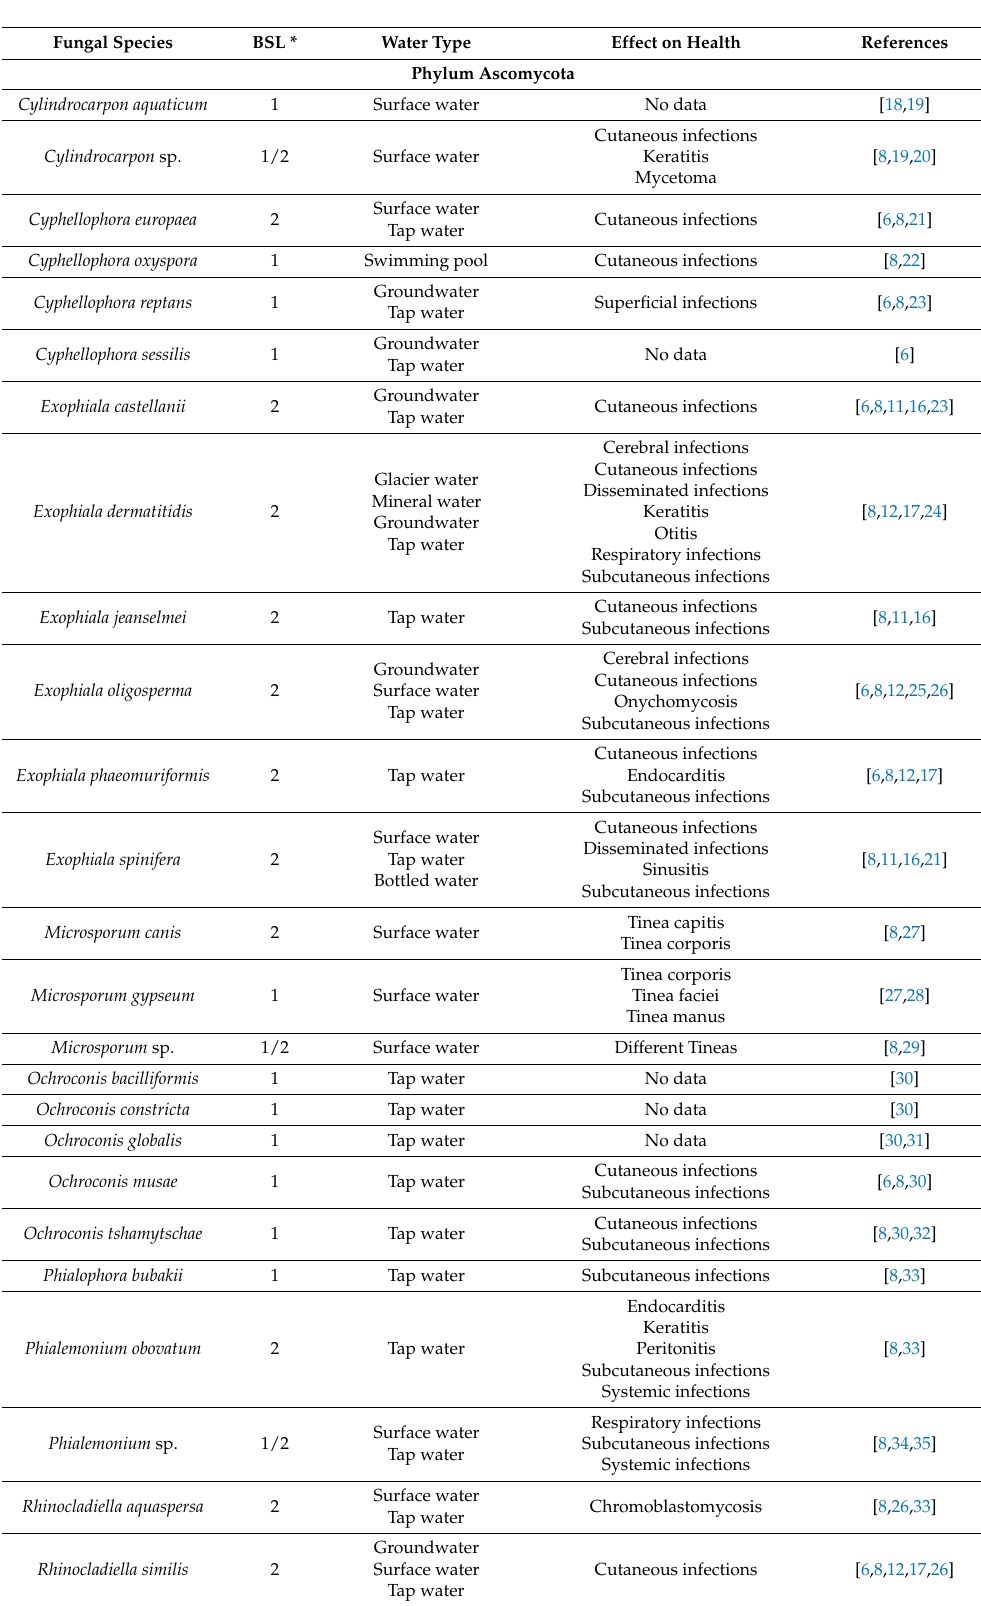
Table 2. Opportunistic waterborne filamentous fungi not reported from food, and their effects on human